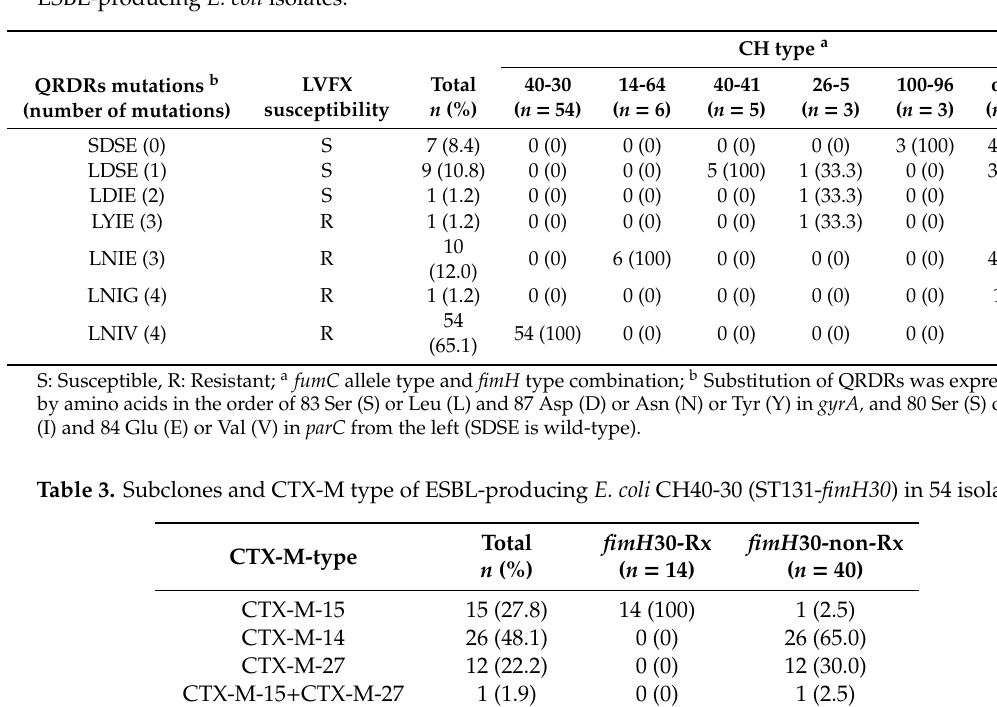
Table 2. Quinolone resistance-determining regions (QRDRs) mutations by CH type in 83 ESBL-producing E. coli isolates.